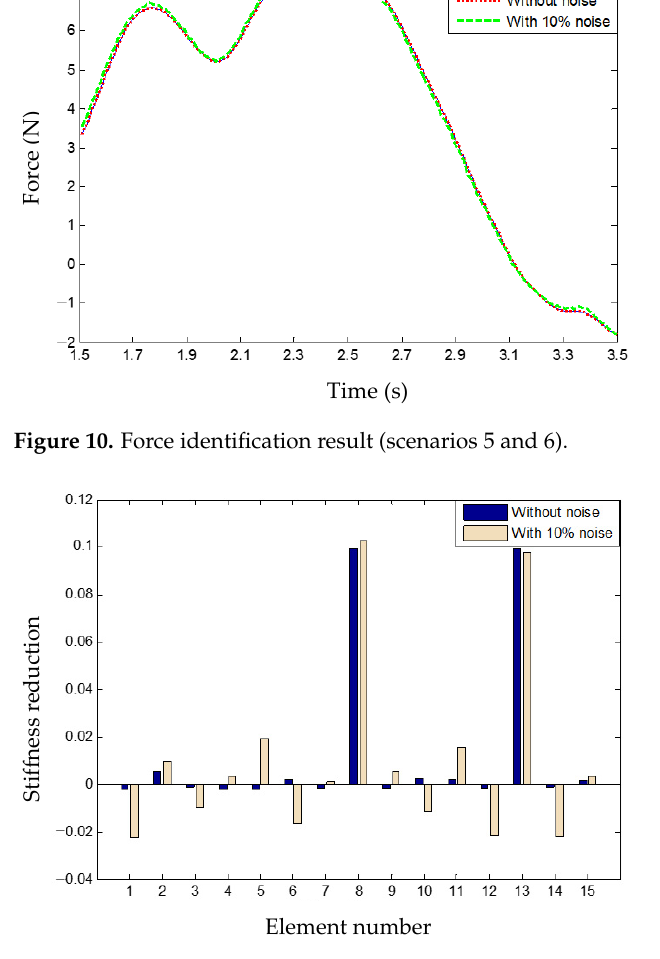
Figure 11. Damage identification result (scenarios 5 and 6). Table 2. Condition assessment of the six scenarios.